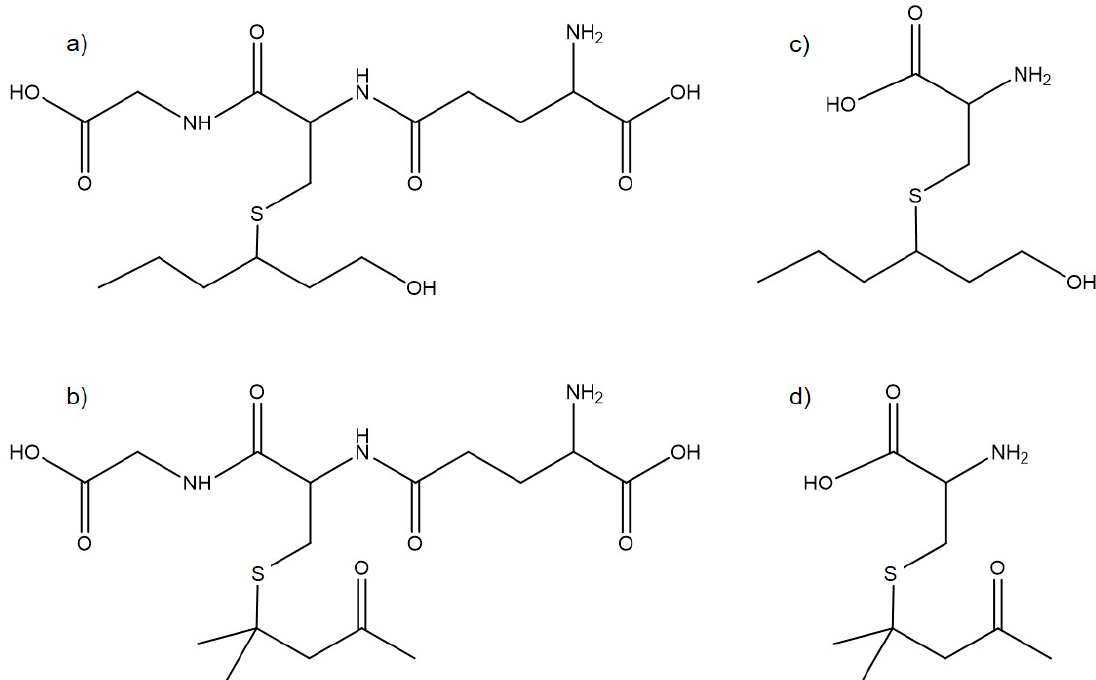
Figure 1. Chemical structure of thiol precursors. ( a ) 3-S-glutathionyl mercaptohexan-1-ol (GSH-3MH), ( b ) 3-S-glutathionyl mercapto-4-methyl-pentan-2-one (GSH-4MMP), ( c ) 3-S-cysteinyl mercaptohexan-1-ol (Cys-3MH), and ( d ) 3-S-cysteinyl mercapto-4-methyl-pentan-2-one (Cys-4MMP) .